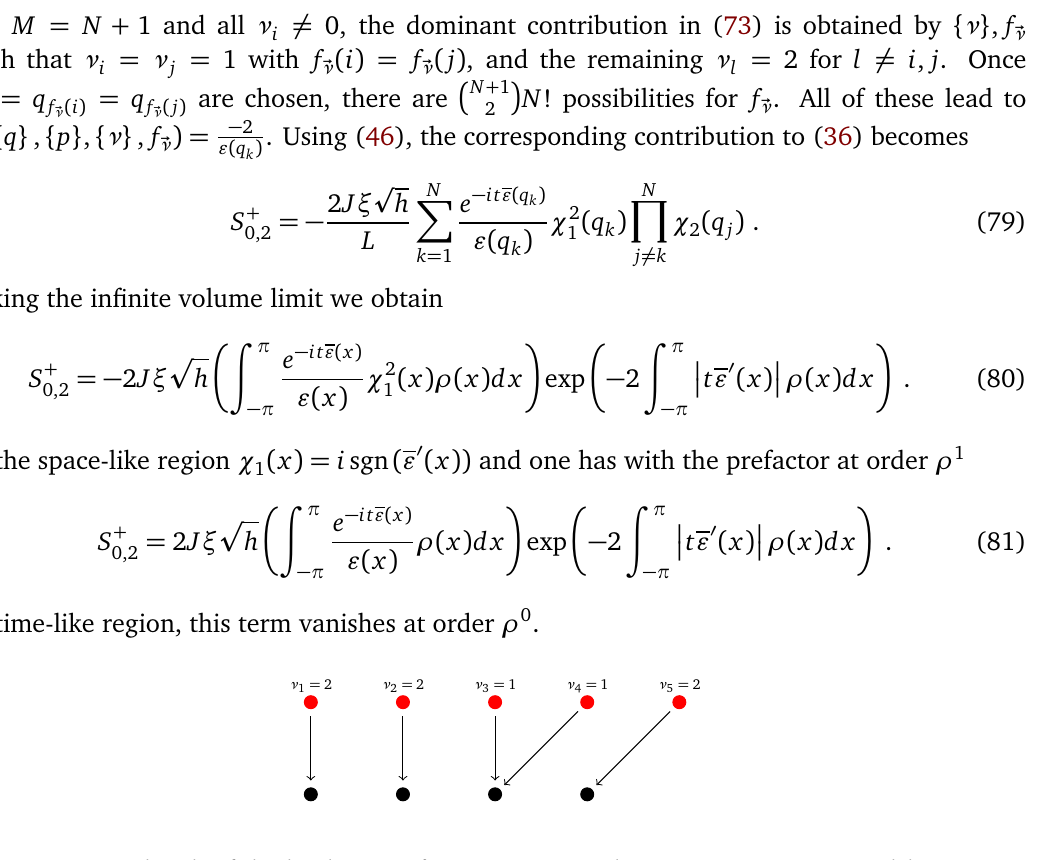
Figure 8: Sketch of the leading configurations contributing to M = N + 1 and k =